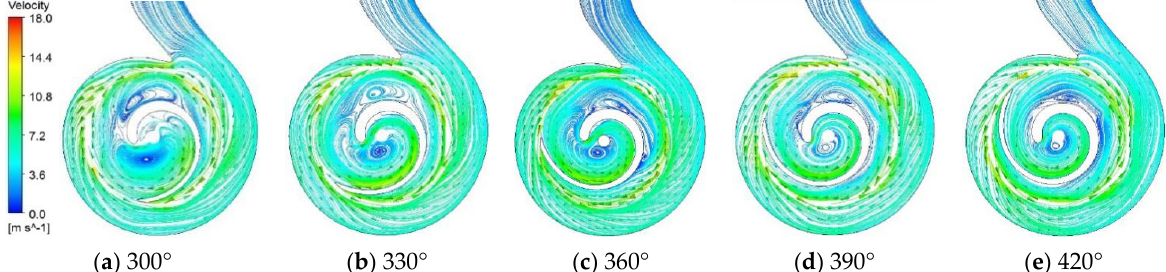
Figure 13. Velocity vector of the pump under part-loading conditions (0.6 Q d ).